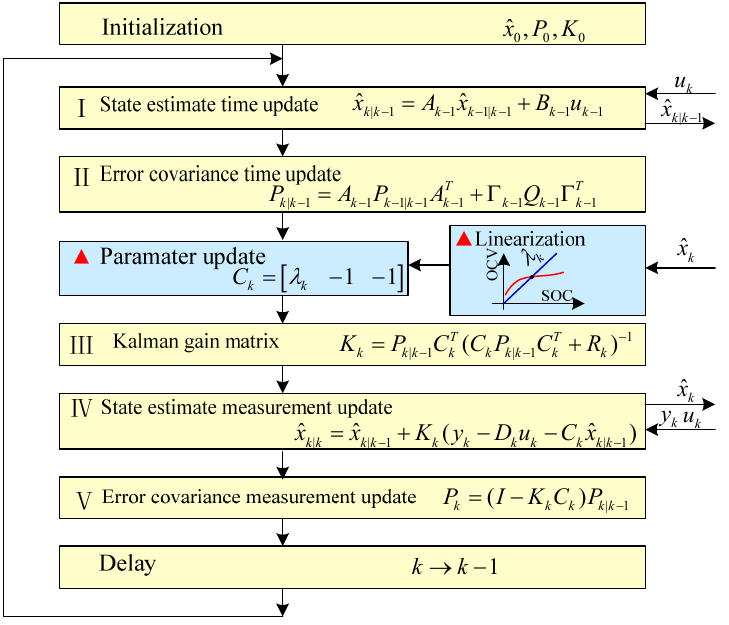
Figure 4. Algorithm flowchart of the Kalman